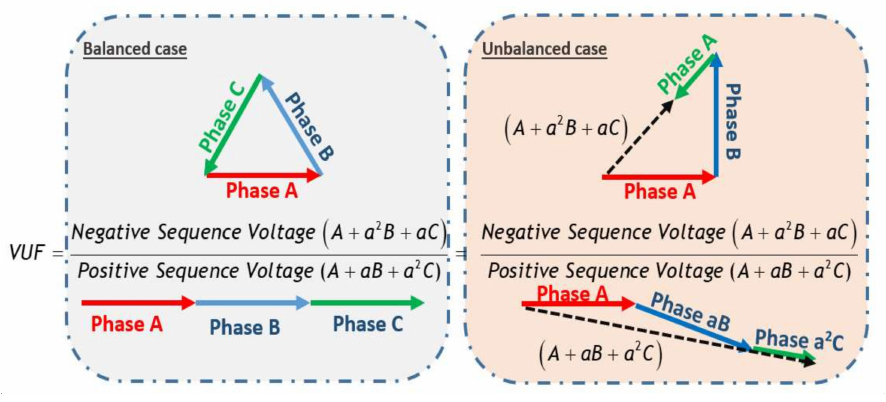
Figure 1. A graphical interpretation of VUF for balanced and unbalanced